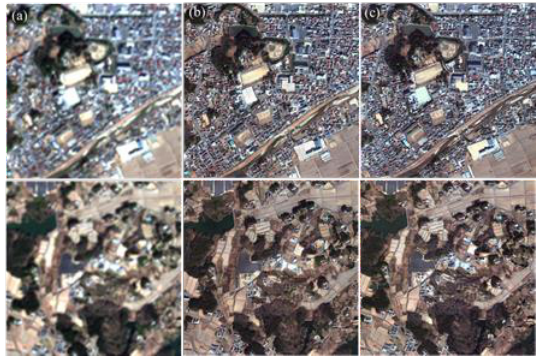
Figure 9 . Validation results of EXP2 (a). S2 LR image (10.0 m) (b). Inference output (2.5m) (c). WV3 Ground truth image (2.5m).